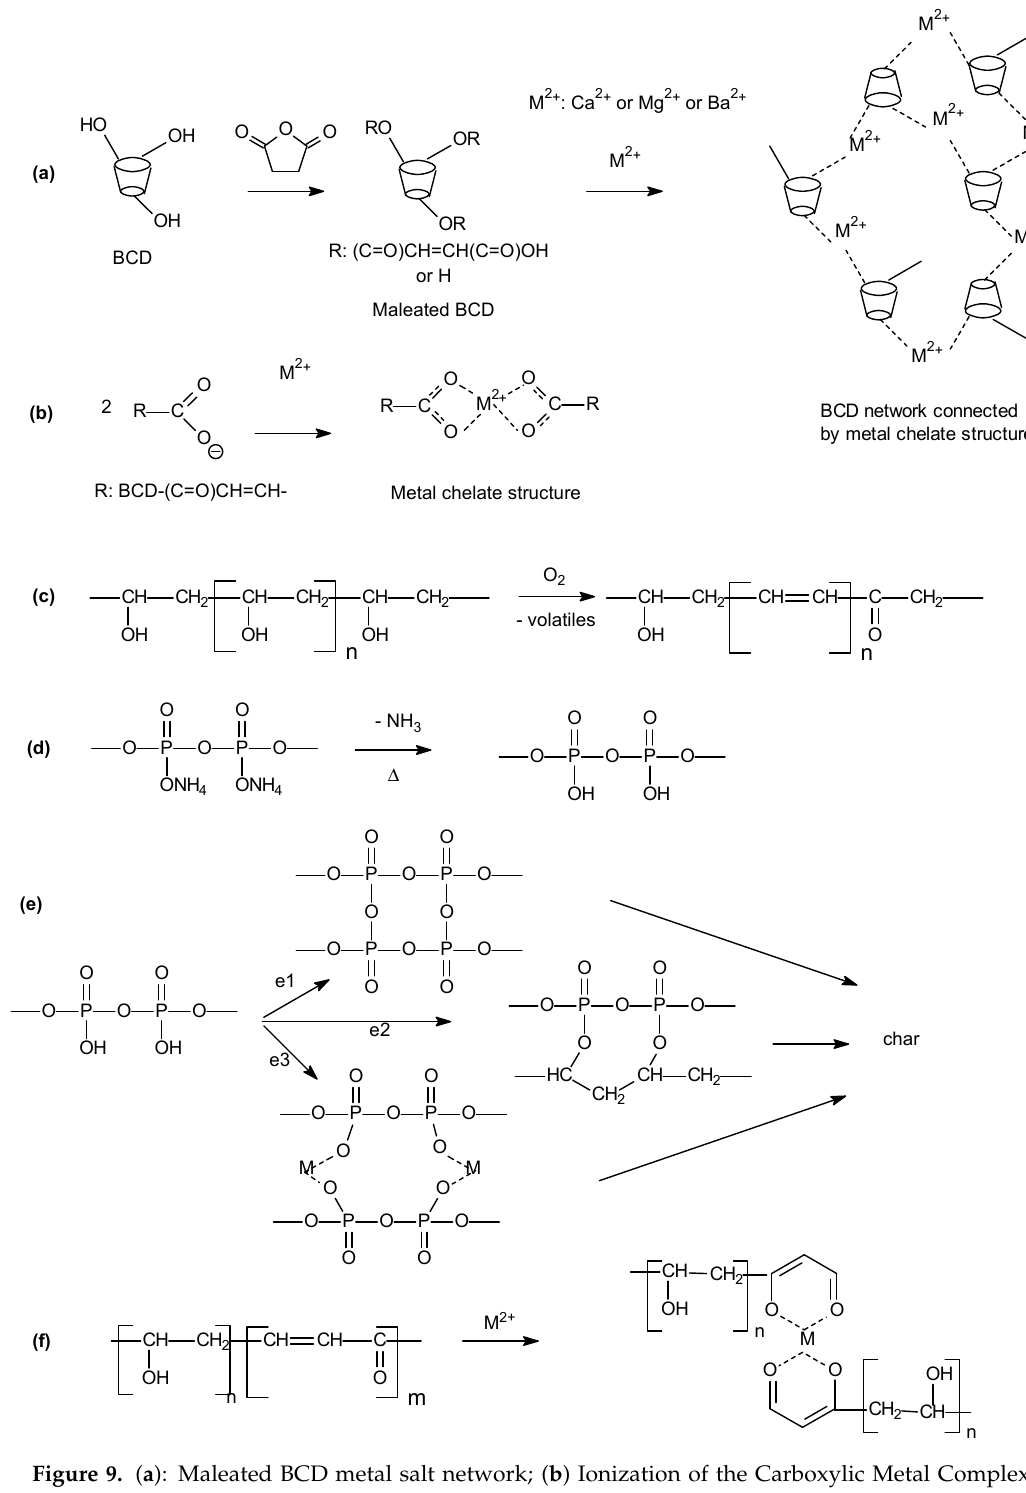
Figure 9. ( a ): Maleated BCD metal salt network; ( b ) Ionization of the Carboxylic Metal Complex. Possible reactions of char formation; ( c ): Poly(vinyl alcohol) (PVA) carbonization; ( d ) APP degradation to polyphosphoric acid (PPA); ( e1 ) PPA self-crosslinking; ( e2 ) PPA crosslinking with PVA; ( e3 ) PPA crosslinking with metal MC complex; and, ( f ) formation of metal polymeric complex. Adapted with permission from ref [74].